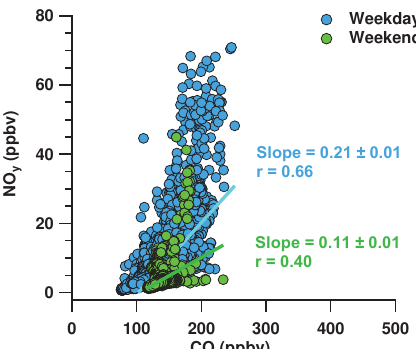
Figure 11. Scatterplot of measured NO y vs. CO using aircraft data from the DISCOVER-AQ P-3 flights. Weekday (blue dots, 8 com- bined days) and weekend (green dots, 4 combined days). Inferred slopes are derived from ODR error-weighted (5% NO y , 2% CO)